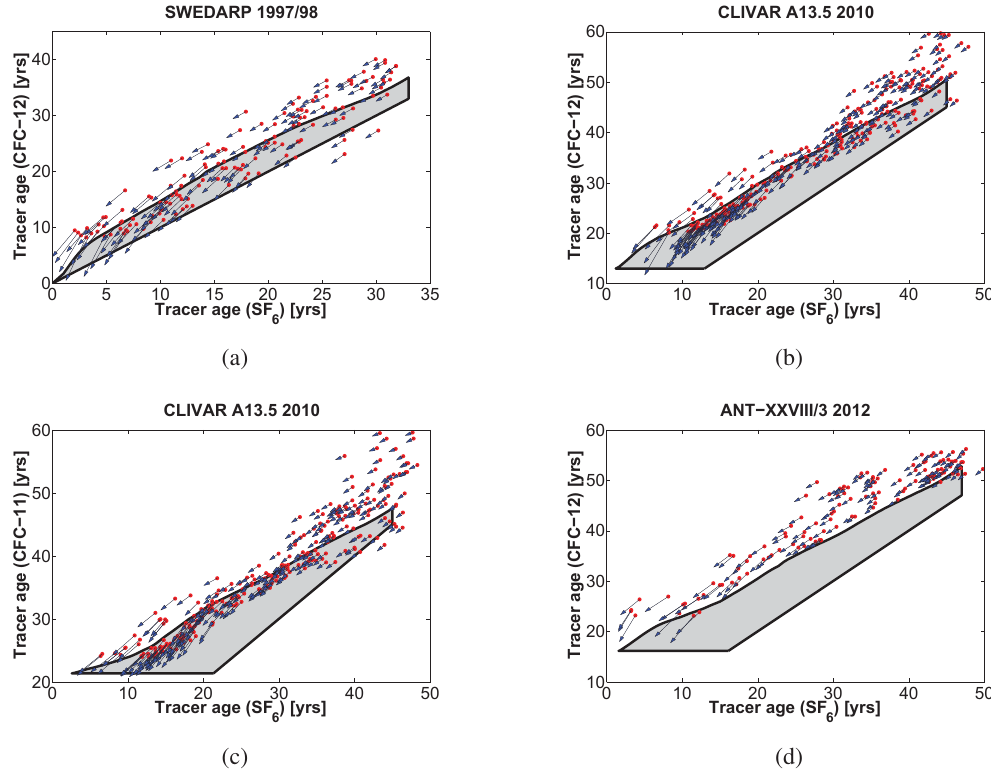
Figure 9. Changes in the tracer age relationships based on saturation corrections. The red dots indicate the relationship of the original and the arrowheads of the saturation corrected data. The data sets are similar to Fig. 7 of ( a ) SWEDARP, ( b , c ) CLIVAR A13.5 and ( d ) ANT-XXVIII/3. The saturation correction affects the Δ / Γ ratios only to minor extent for a SF age > 20 years but shows a shift towards lower Δ / Γ ratios below this limit.